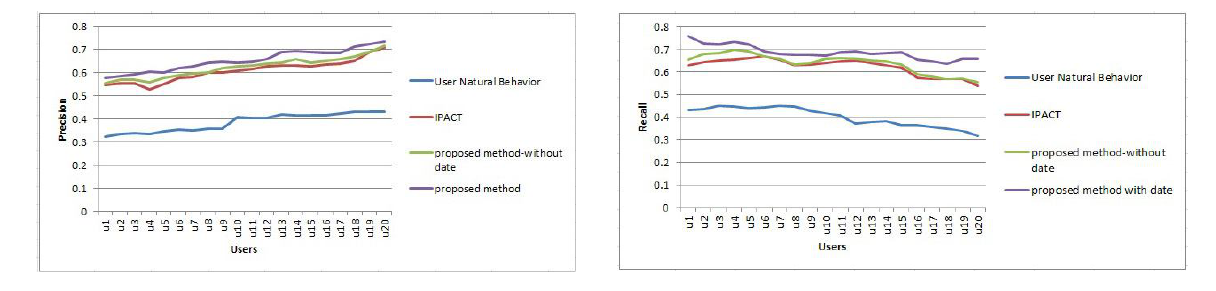
Fig. 5. Comparison Chart of the number of users using the recall